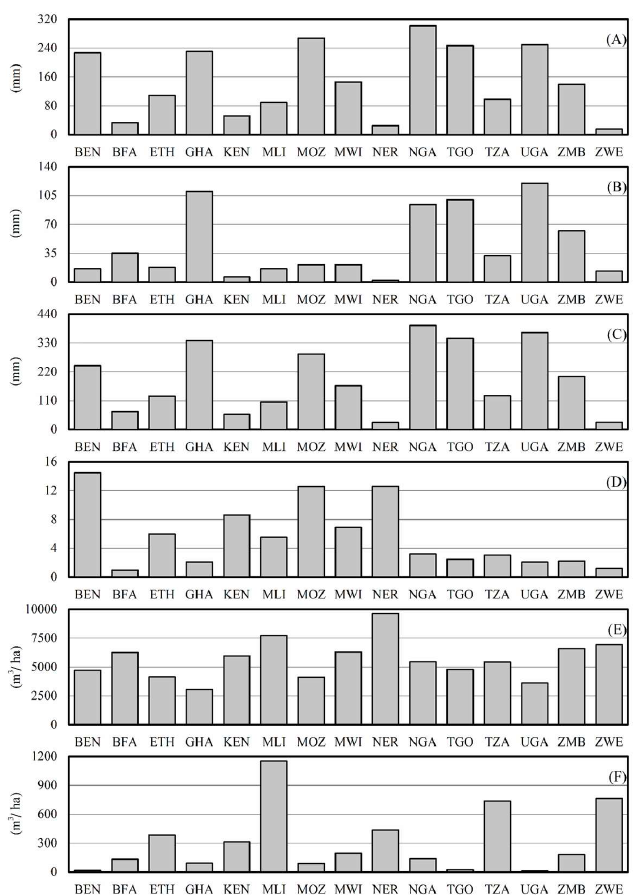
Figure 2. Annual mean depth (mm) of ( A ) renewable surface water resources (RSW), ( B ) renewable groundwater resources (RGW), and ( C ) renewable surface and groundwater resources; ( D ) renewable surface water to groundwater ratio; ( E ) annual irrigation water demand per hectare (IWD, m 3 /ha); and ( F ) annual water supplement demand per hectare for rain-fed farming (RF ISW , m 3 /ha).